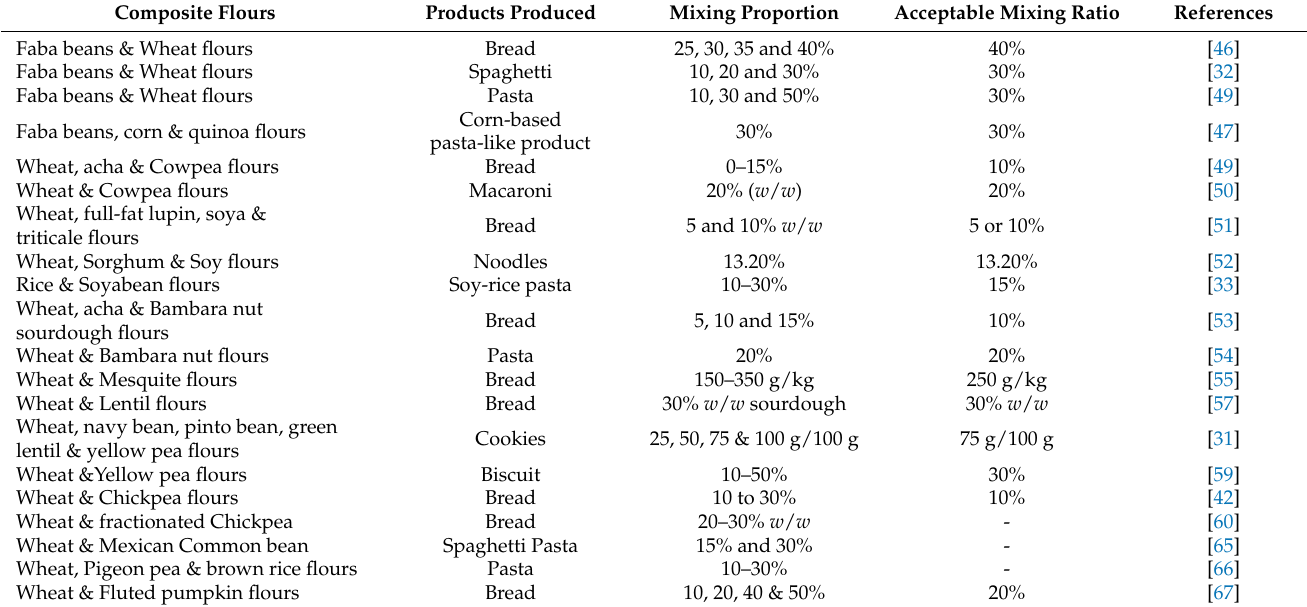
Table 3. Summary of the utilization of legumes and pulses in bread baking and pastry foods.